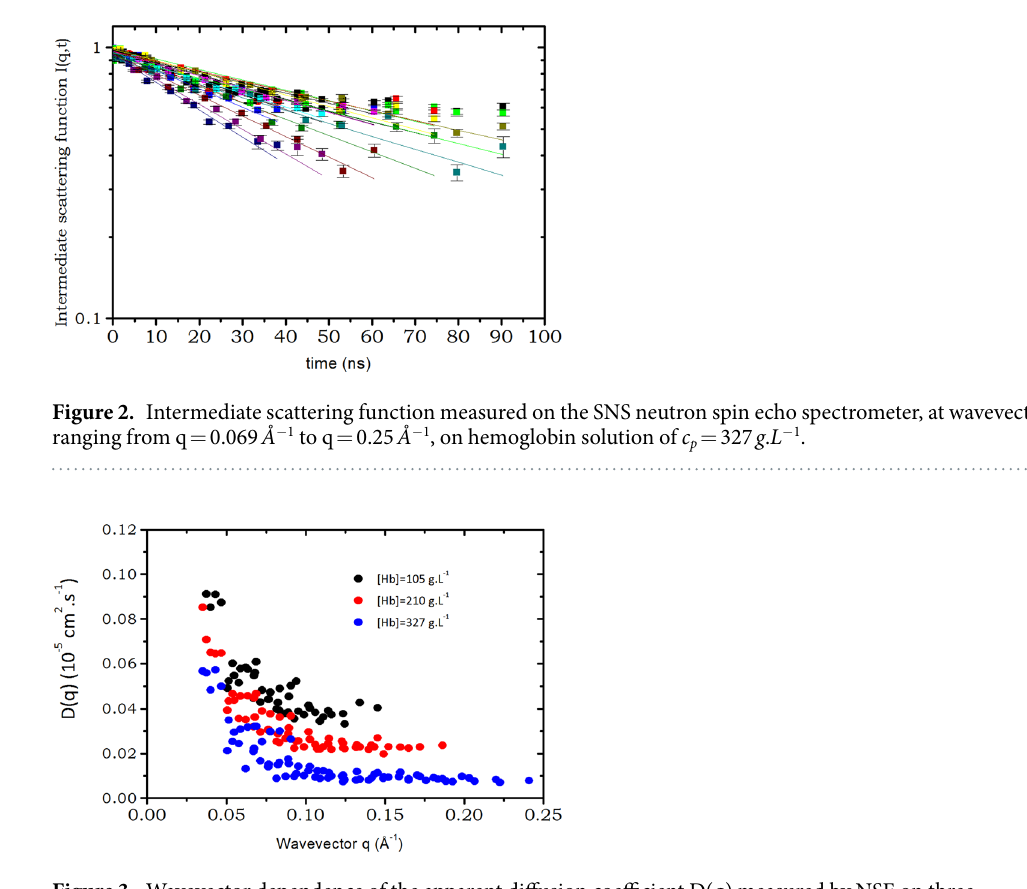
Figure 3. Wavevector dependence of the apparent diffusion coefficient D(q) measured by NSE on three solutions of concentration c p = 105 g . L − 1 , c p = 210 g . L − 1 and c p = 330 g . L − 1 . The value obtained for q → 0 is the mutual or collective diffusion coefficient whereas the value of the plateau corresponds to the long time self- diffusion coefficient at a given concentration D s ( c p ) (see